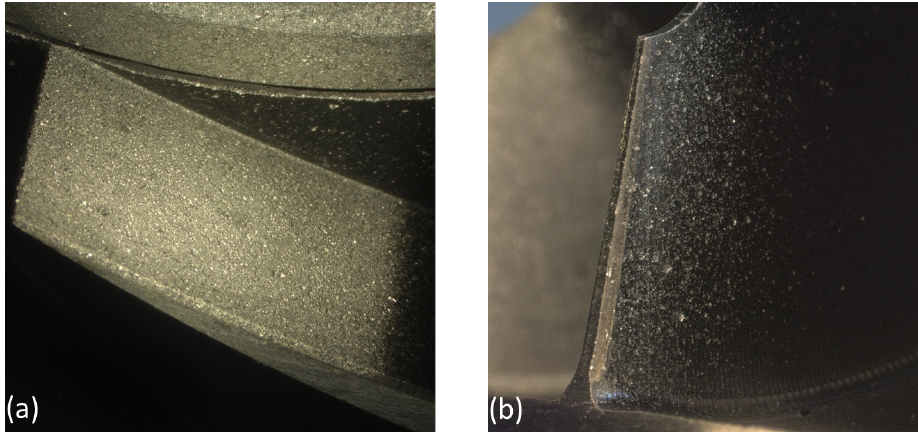
Figure 12. Droplet erosion in a fuel cell turbocharger turbine. ( a ) Eroded suction side near the stator vane trailing edge. ( b ) Eroded suction side near the leading edge of a rotor blade. Adapted from